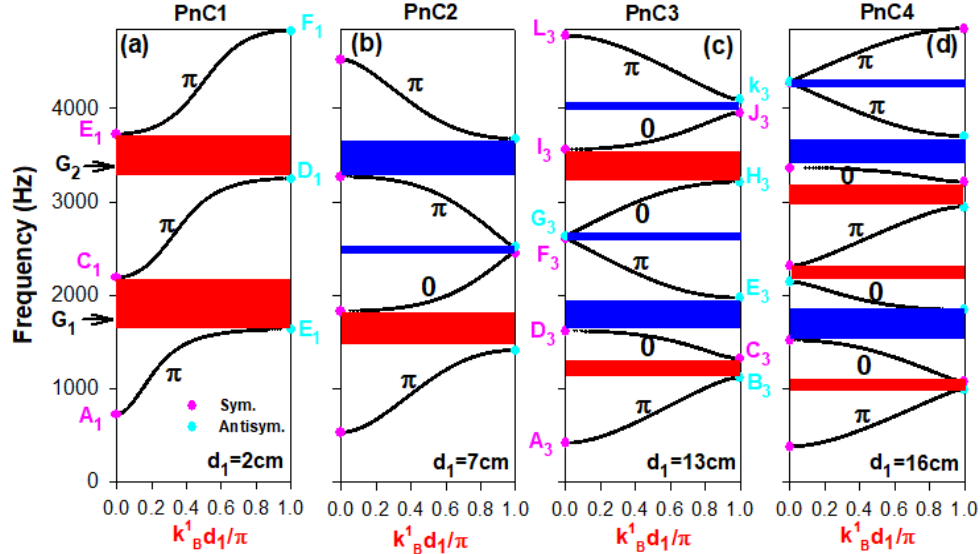
Figure 3. ( a – d ) Band structures for four infinite PnCs with different values of the period d 1 and = 10 cm. The Zak phases of each bulk band are labeled π or 0 in black. The pink (cyan) dots at the d (cid:48) 1 band edges represent the symmetric (antisymmetric) states. G1 and G2 indicate the position of the first and second common bandgaps. The bandgaps are colored in blue or red depending on whether the signs of the reflection phases of the semi-infinite PnCs are negative or